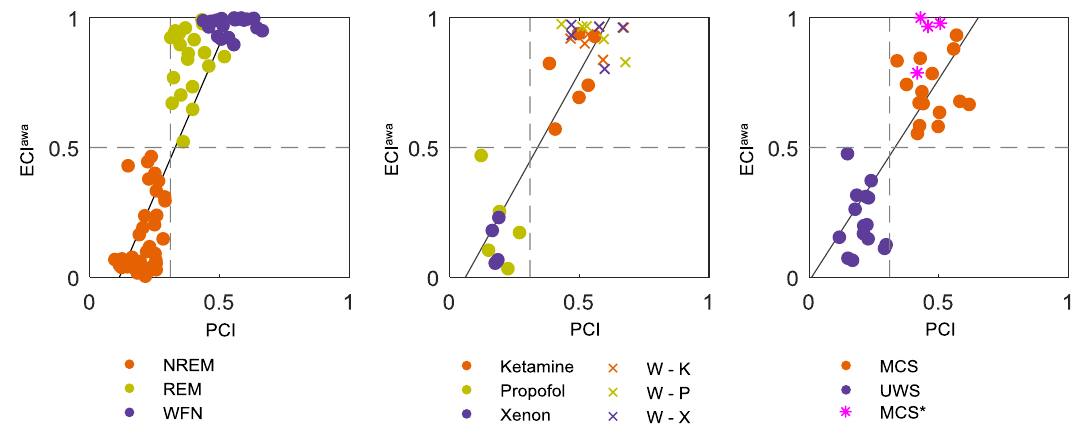
Fig. 3 Correlation between ECI awa and PCI from TMS – EEG. During sleep and healthy wakefulness (left), under anesthesia, and wakefulness before anesthesia (middle), and in severely brain-injured patients (right), ECI awa was compared to PCI. The gray horizontal and vertical dashed lines represent the optimal cutoff of ECI awa and PCI to discriminate between low and high awareness, respectively. The solid lines represent linear fi ts to the data. W healthy wakefulness, W – K healthy wakefulness before ketamine, W – P healthy wakefulness before propofol, W – X healthy wakefulness before xenon, MCS patients in a minimally conscious state, UWS patients with unresponsive wakefulness syndrome, MCS* non-behavioral